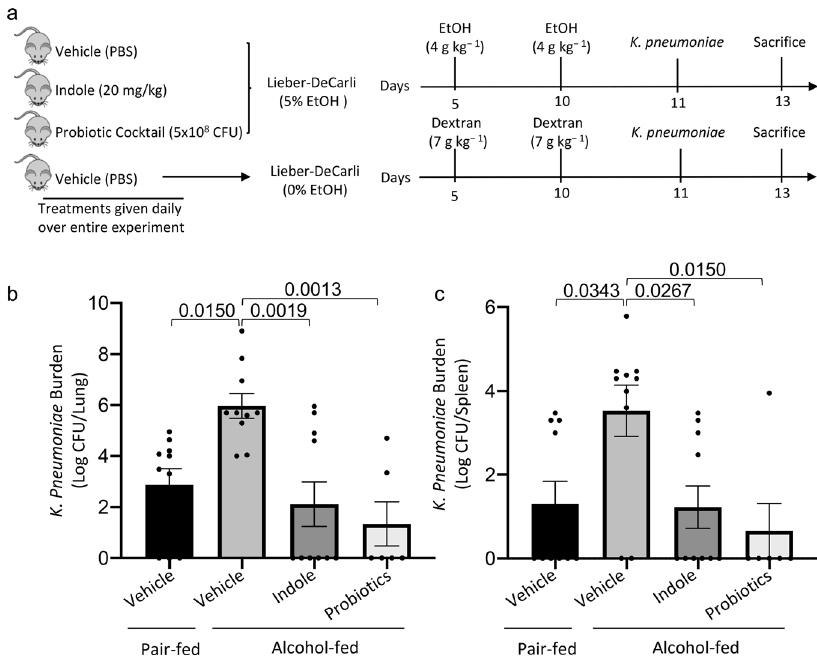
Fig. 1 Microbiota supplementation mitigates alcohol-associated pneumonia. Binge-on-chronic alcohol-fed mice with and without treatment were infected with Klebsiella and sacri fi ced 48 h post-infection. a Experimental schema. b Klebsiella lung burden (Log CFU/ml). c Klebsiella splenic burden (Log CFU/ml). Bars represent the mean ± SEM and dots represent individual mice. P values are indicated in the fi gure and were determined by one ‐ way ANOVA with Sidak ’ s multiple comparison test. N = 10/group.